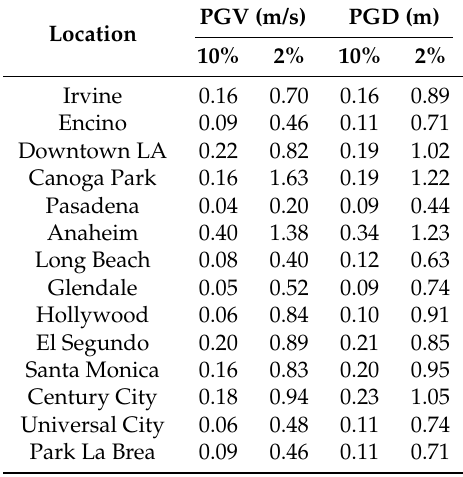
Table 4. Probabilistic estimates of PGV and peak ground displacements (PGD) at 14 stations in southern California with probabilities of exceedance of 10% and 2% in 30 years from earthquakes on the San Andreas